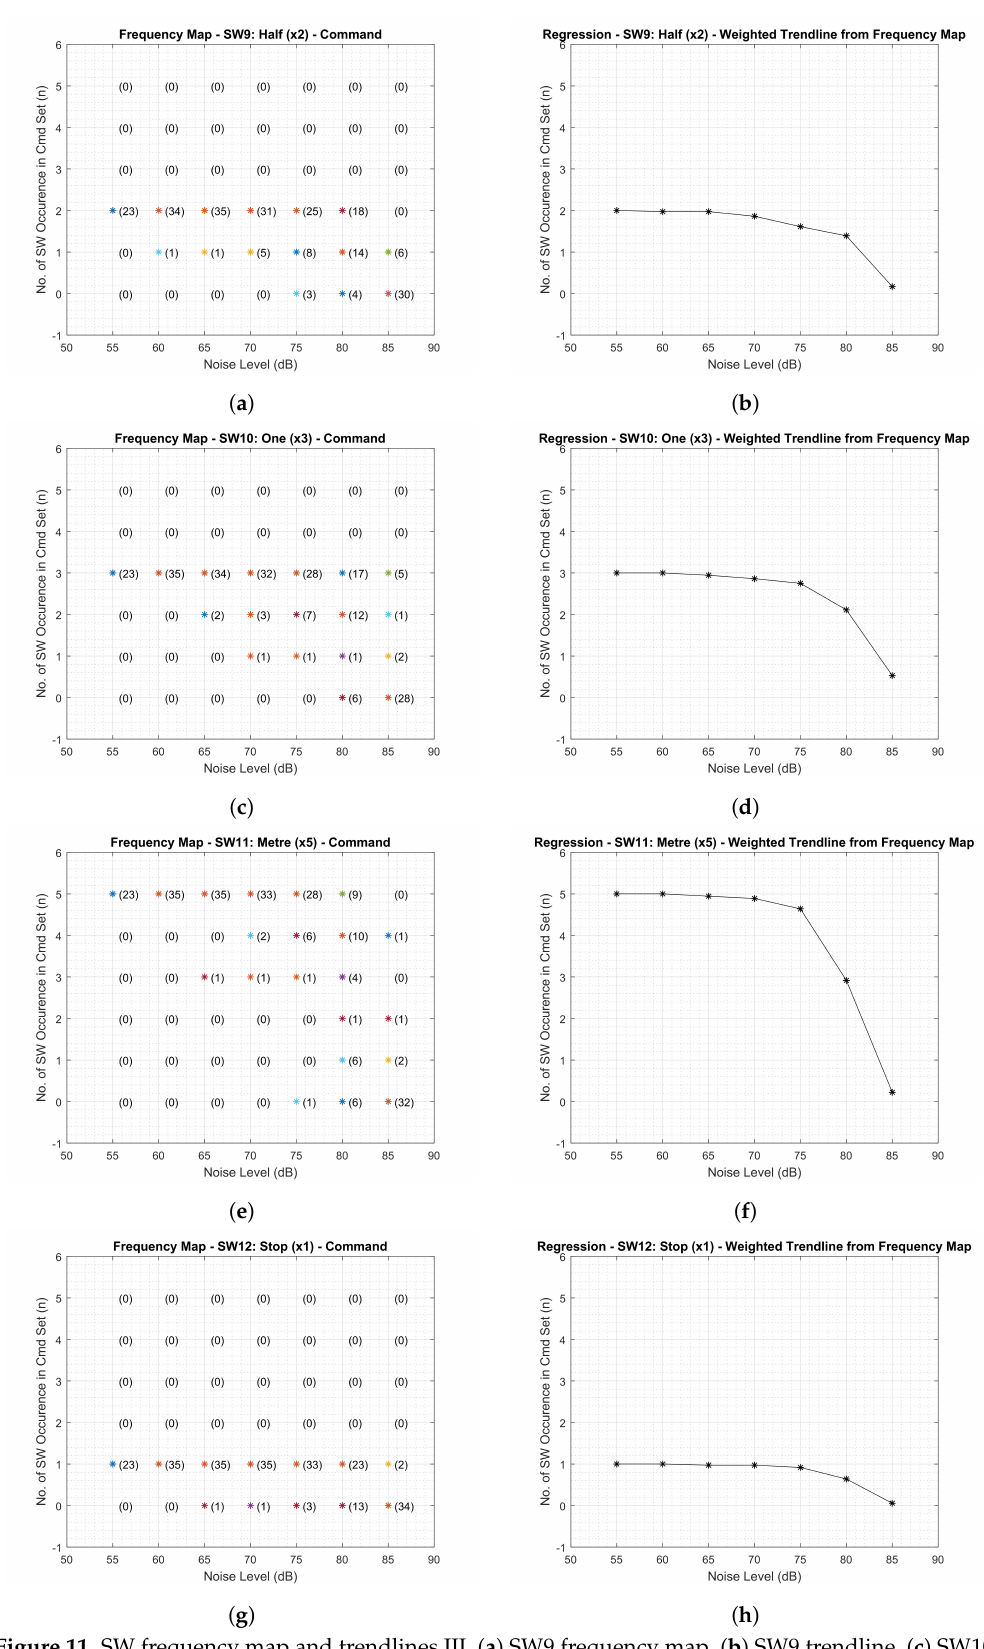
Figure 11. SW frequency map and trendlines III. ( a ) SW9 frequency map, ( b ) SW9 trendline, ( c ) SW10 frequency map, ( d ) SW10 trendline, ( e ) SW11 frequency map, ( f ) SW11 trendline, ( g ) SW12 frequency map, ( h ) SW12